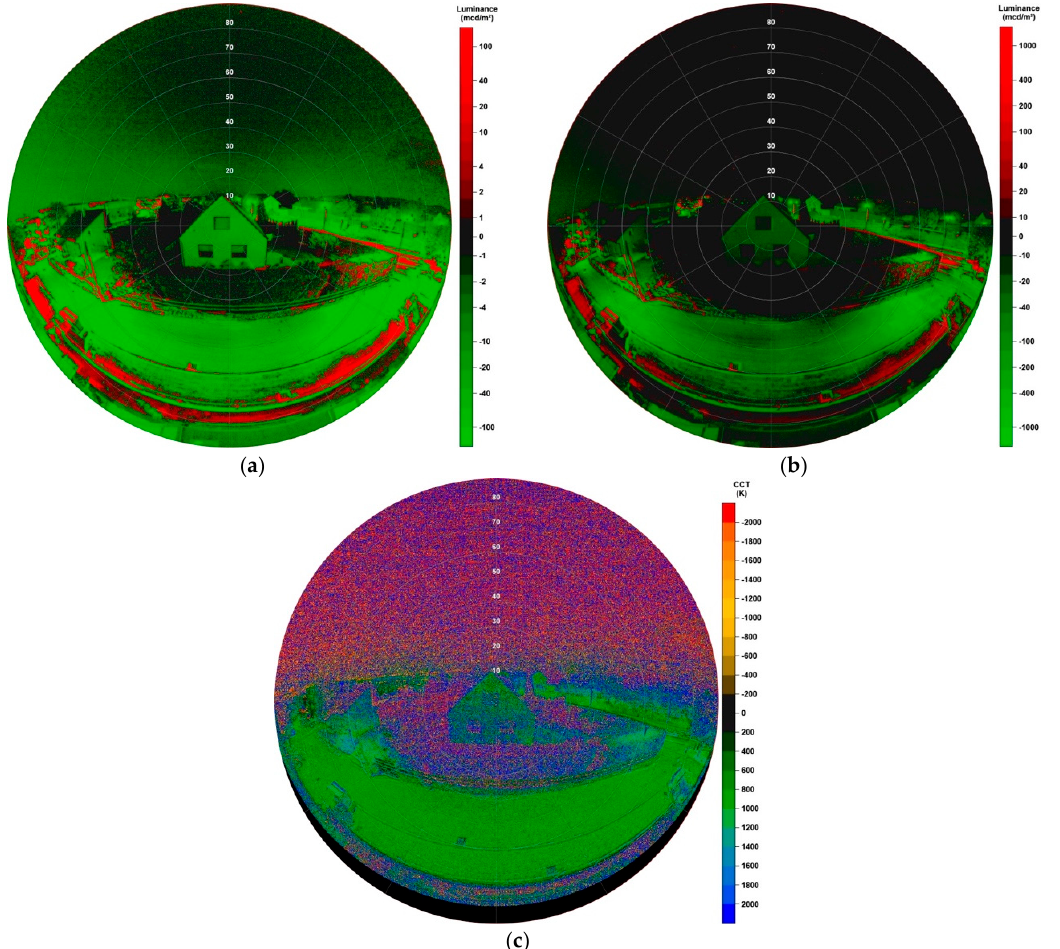
Figure 19. Subtraction of image after transition and image before transition, showing the differences in luminance and CCT. ( a ) Shows luminance comparison with lower scale; ( b ) shows luminance comparison with higher scale; ( c ) shows CCT comparison. Calculation was image after transition (Figure 18) minus image before transition (Figure 17).